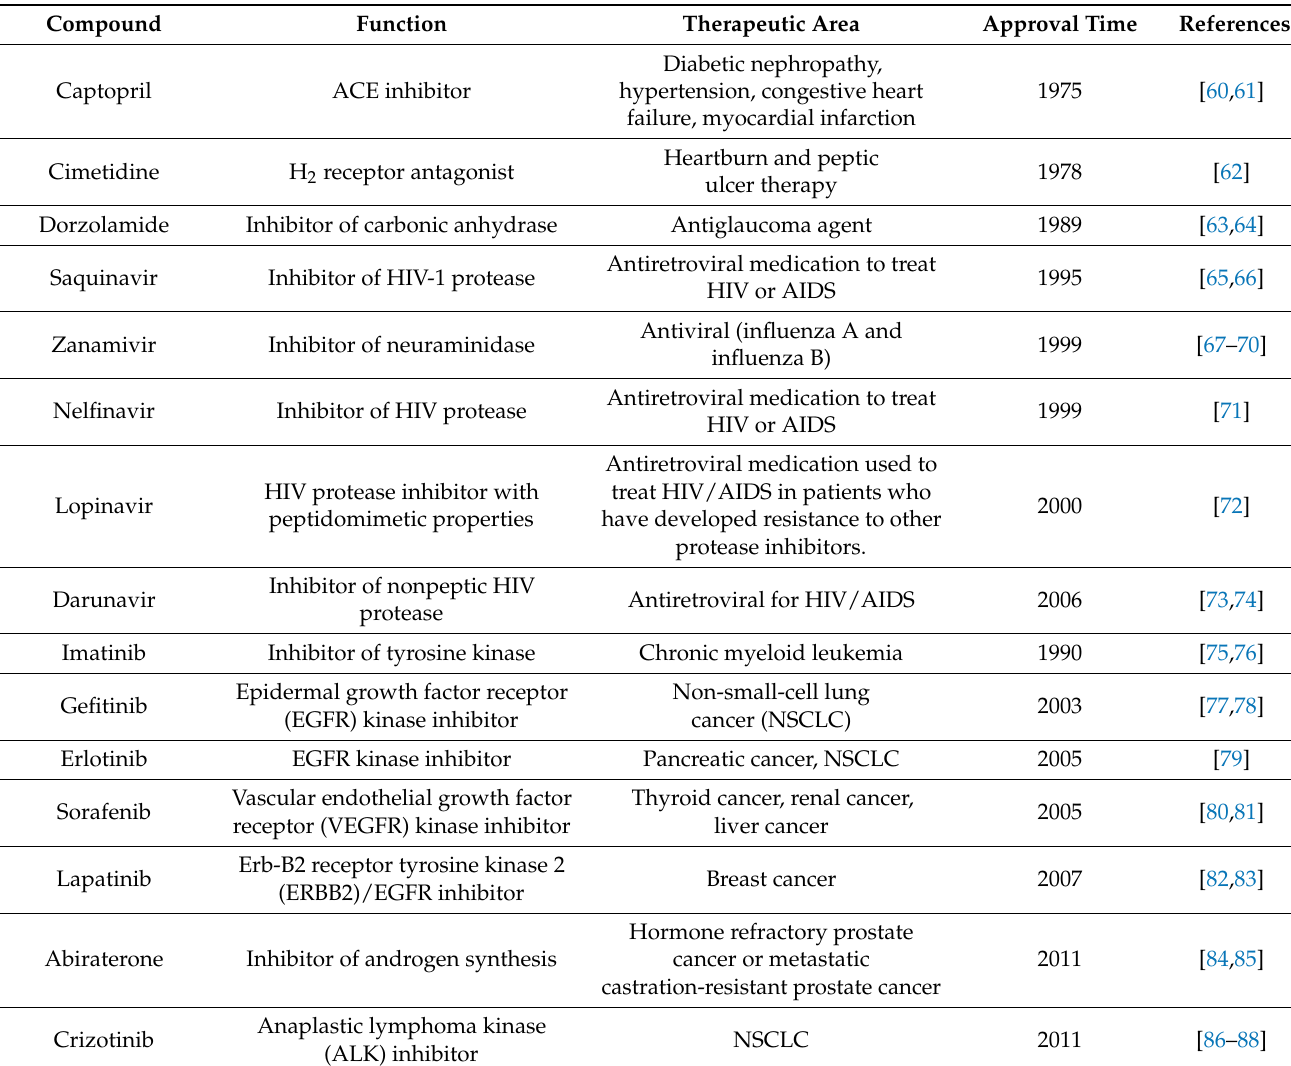
Table 3. Selected inhibitors developed using computational chemistry and rational drug design strategies